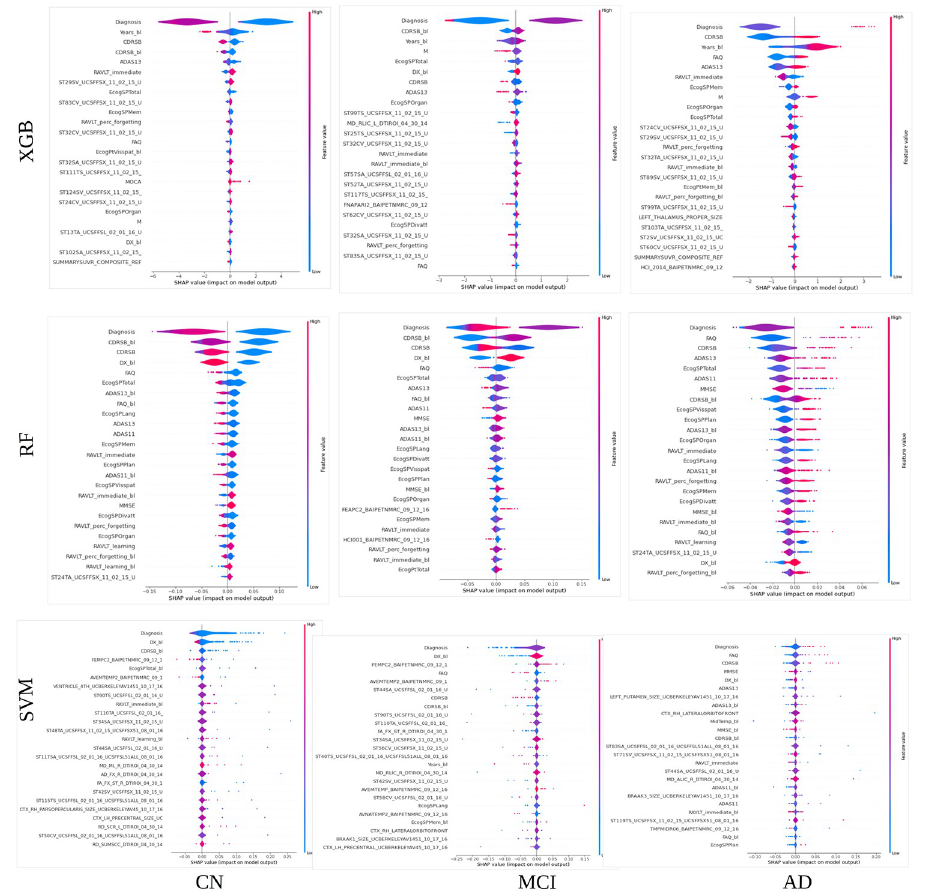
Fig 7. XGB, RF, and SVM explainability. The violin plots show the SHAP value impact on the estimation of the probabilities for each class of the XGB, RF, and SVM models. Models trained with all the features. Long feature names have been trimmed for better